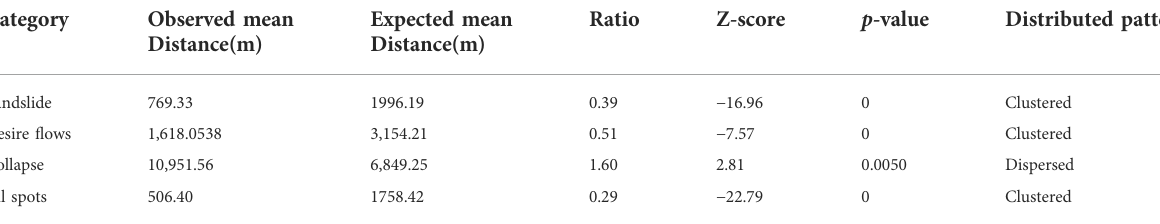
TABLE 3 Spatial characteristics of PGDSs distribution using the